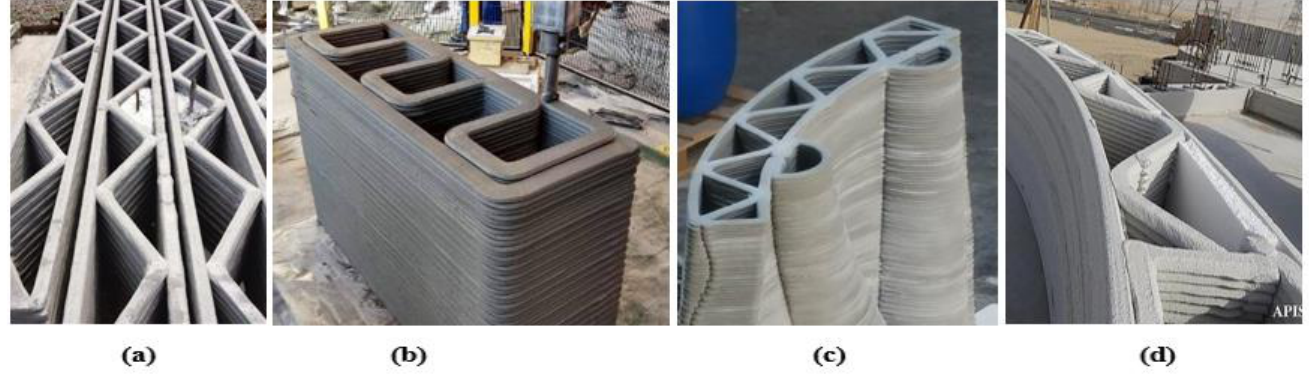
Figure 1. Examples of 3DPC wall panels with different cross-sectional arrangements: ( a ) triangular-shaped [25]; ( b ) lattice-shaped 3DPC wall by ETESIAS [26]; ( c ) sinusoidal-shaped 3DPC wall by Gosselin et al. [27]; ( d ) sinusoidal shaped, from the world’s largest 3DPC building in Dubai [28].